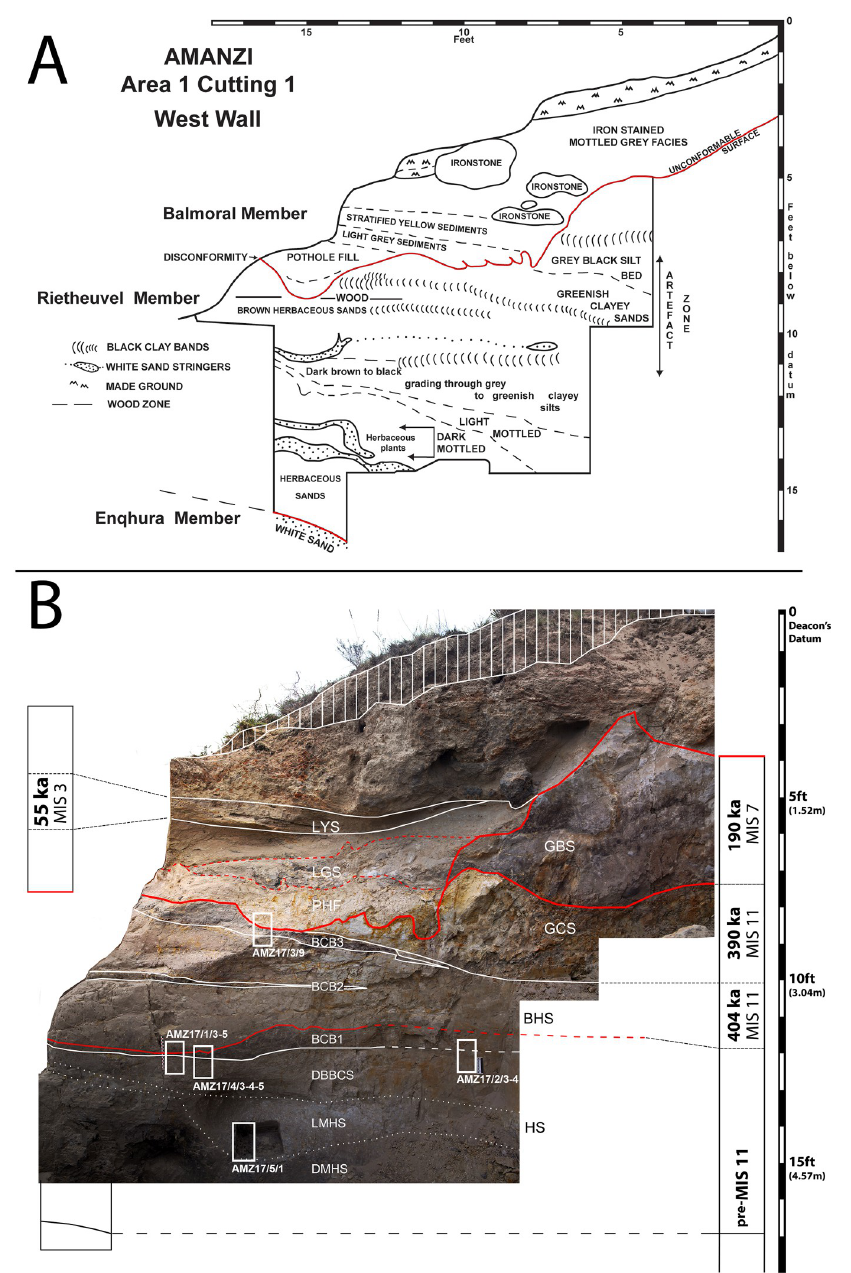
Fig 3. Amanzi Area 1 profile of the western section wall of Cutting 1. A) Redrawn section from Deacon [11]; B) Photomosaic of present-day situation, with indication of the stratigraphic units and members described in this paper, main disconformity (red line) and location of micromorphology samples (white